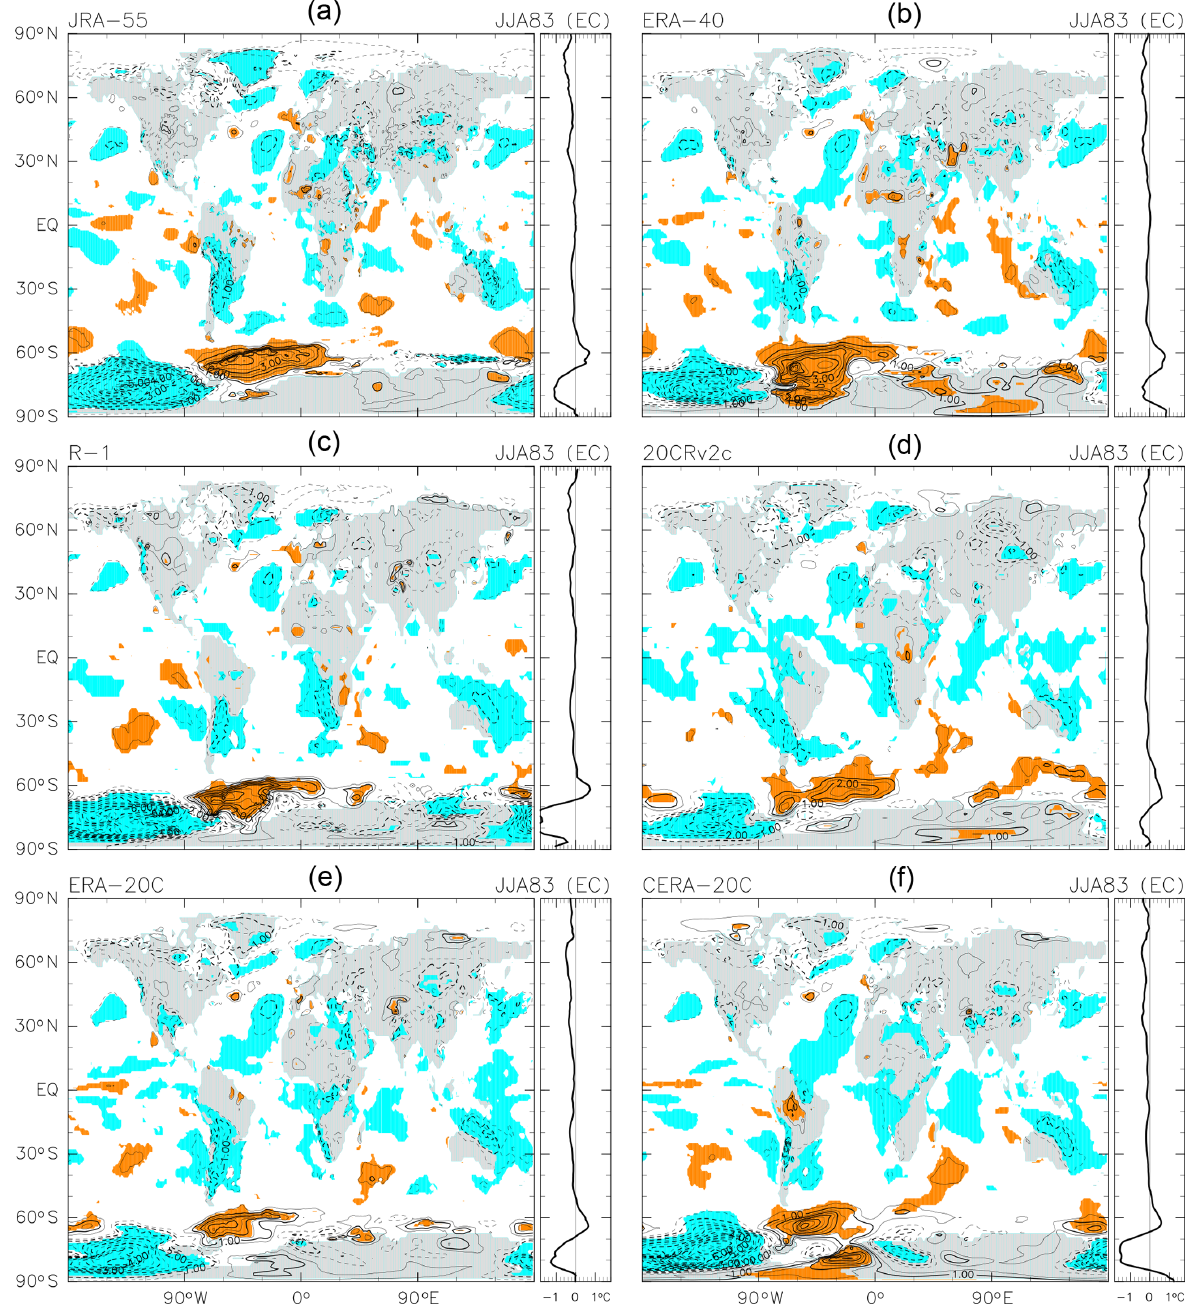
Figure 7. As for Fig. 4, but based on the 1958–2001 MLR analysis for each of six reanalysis data sets. The contour interval is 0.5K, without 0.0K lines. Coloured shading denotes anomalies that are positive (orange) or negative (blue) with magnitudes exceeding 1 SD of the 3-month mean R(t) at that